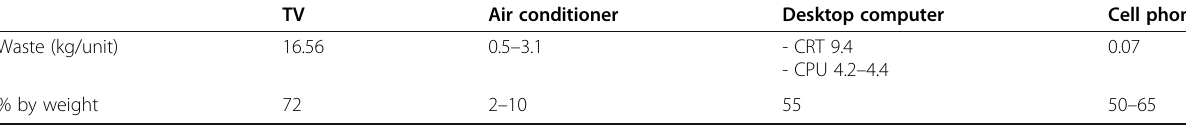
Table 3 Discarded waste from e-waste separation and